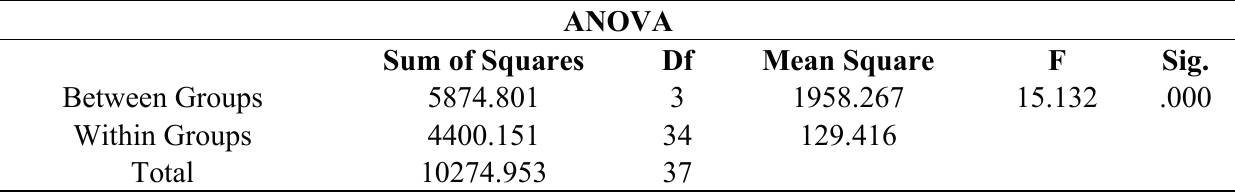
Table 6. Analysis of variance of noise levels across land